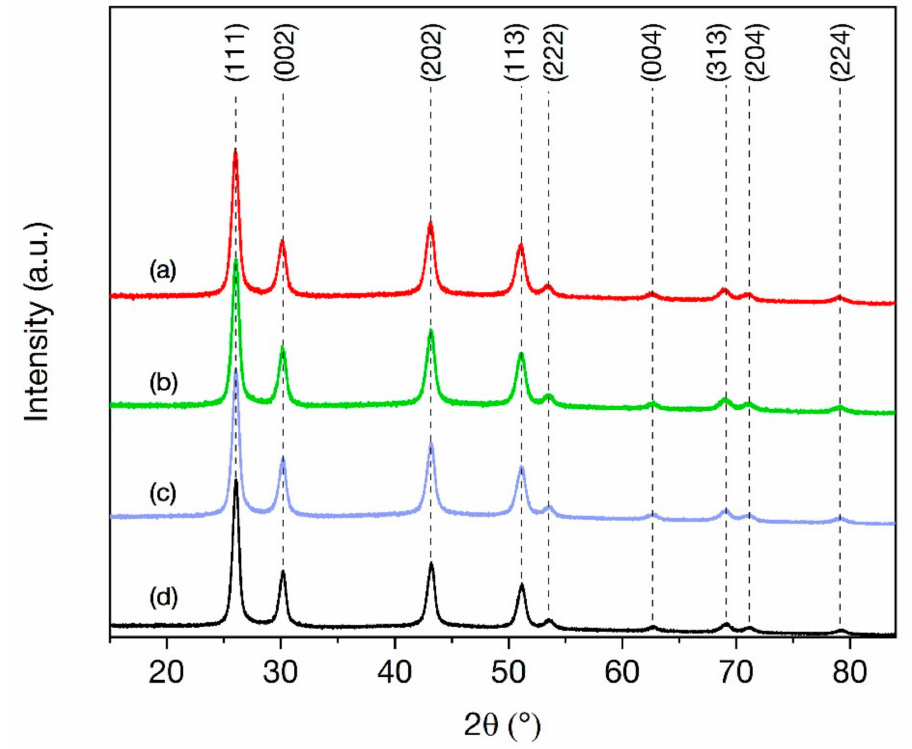
Figure 1. XRD patterns of the synthesized samples ( a ) BaGdF 5 :Eu, ( b ) BaGdF 5 :Tb, and ( c ) BaGdF 5 :Sm. For comparison, the ( d ) BaGdF 5 profile is